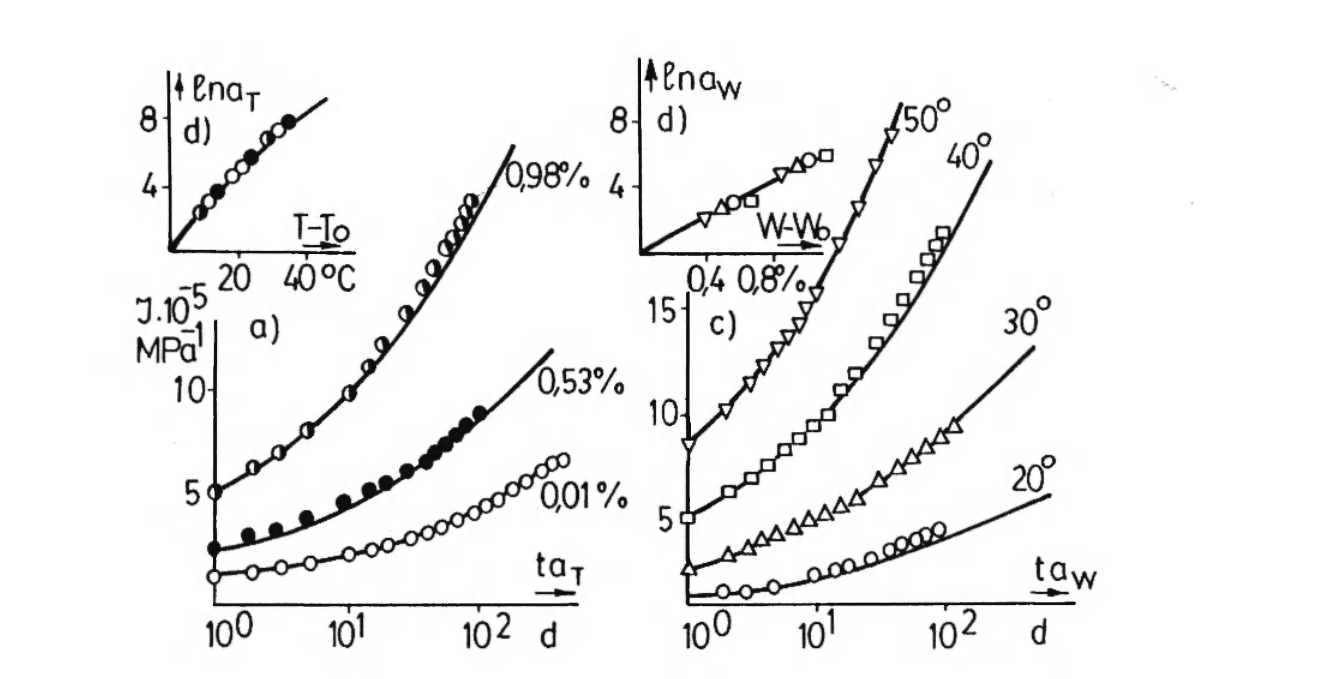
Fig. 1: Master curves (a,c) and shift functions (b,d), obtained by means of time-temperature analogy (a,b) and of time-moisture analogy (c,d); experimental values from control tests are shown.